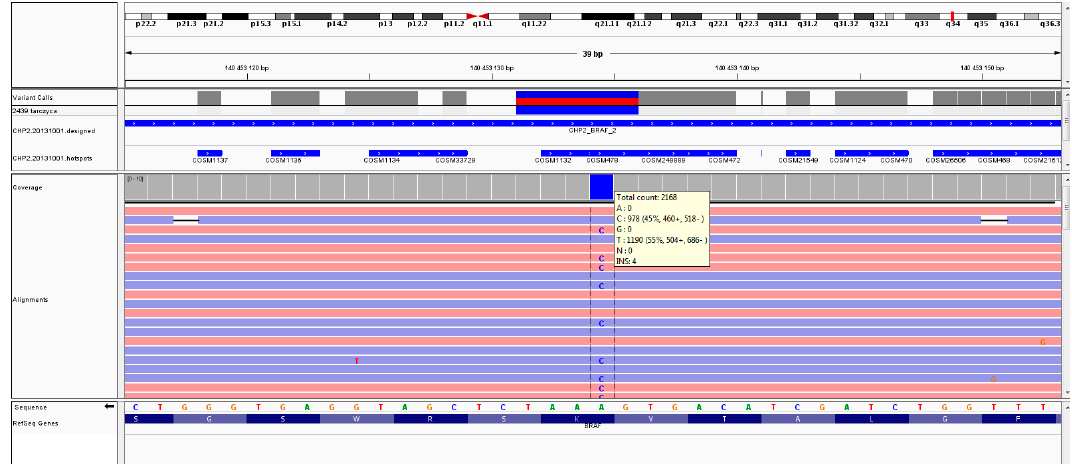
Figure 4. Screen shot of the next-generation sequencing missense mutation p.K601E (c.1801A>G p. Lys 601Glu) detected in BRAF . NGS data showing reads (- strand designated in blue, + strand in red) mapped to the oncogene reference sequence are shown below the panel box depicted by Integrative Genomics Viewer. Because of the opposite DNA strand orientation, the mutation is presented as T>C instead of A>G on the figure.